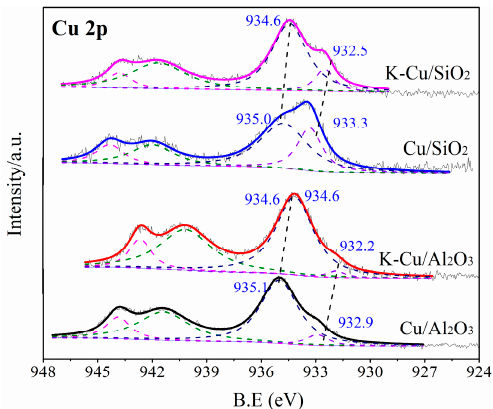
Figure 5. Cu2p 3/2 X-ray photoelectron spectroscopy (XPS) spectra of Cu/Al 2 O 3 , K-Cu/Al 2 O 3 and Cu/SiO 2 , K-Cu/SiO 2 catalysts .